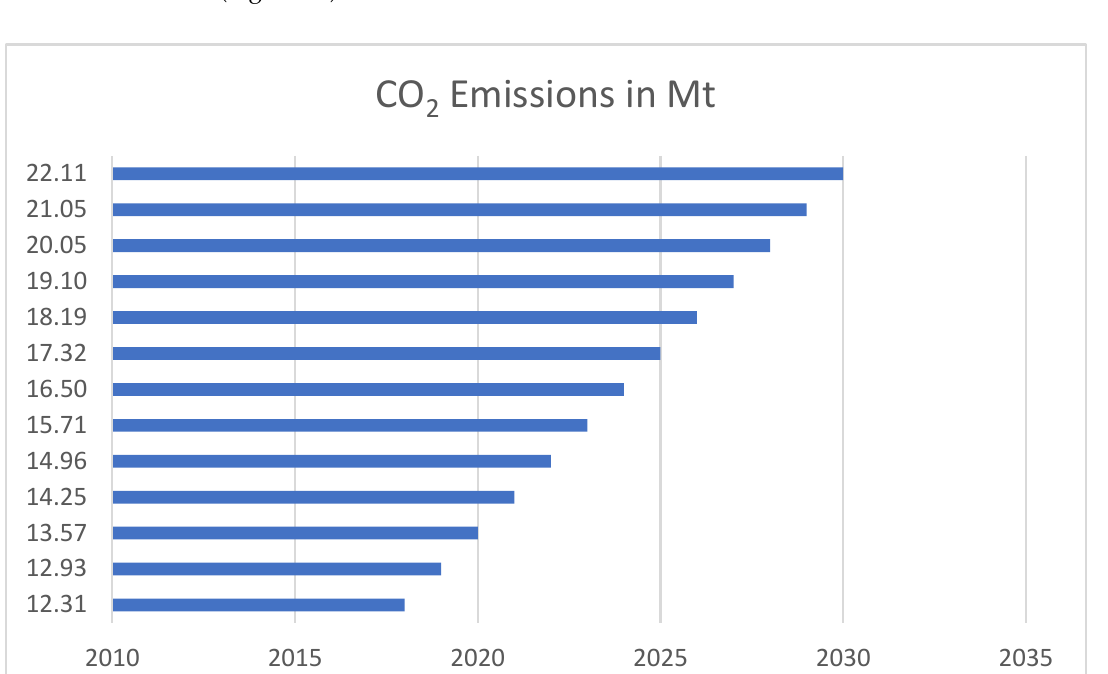
Figure 10. CO 2 emissions forecast: cement industry and cement production.